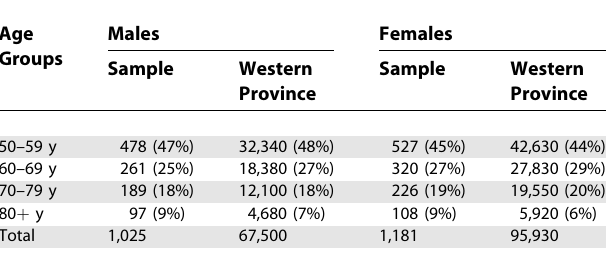
Table 1. Age and Gender Composition of Population in Sample and in Survey